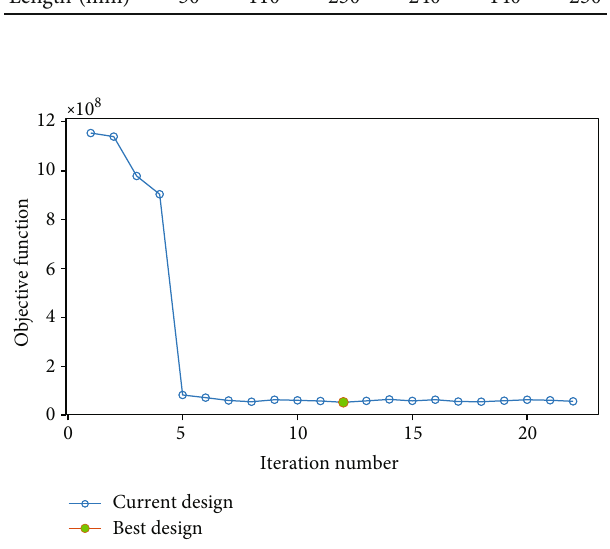
Figure 26: Objective function vs. number of iterations.